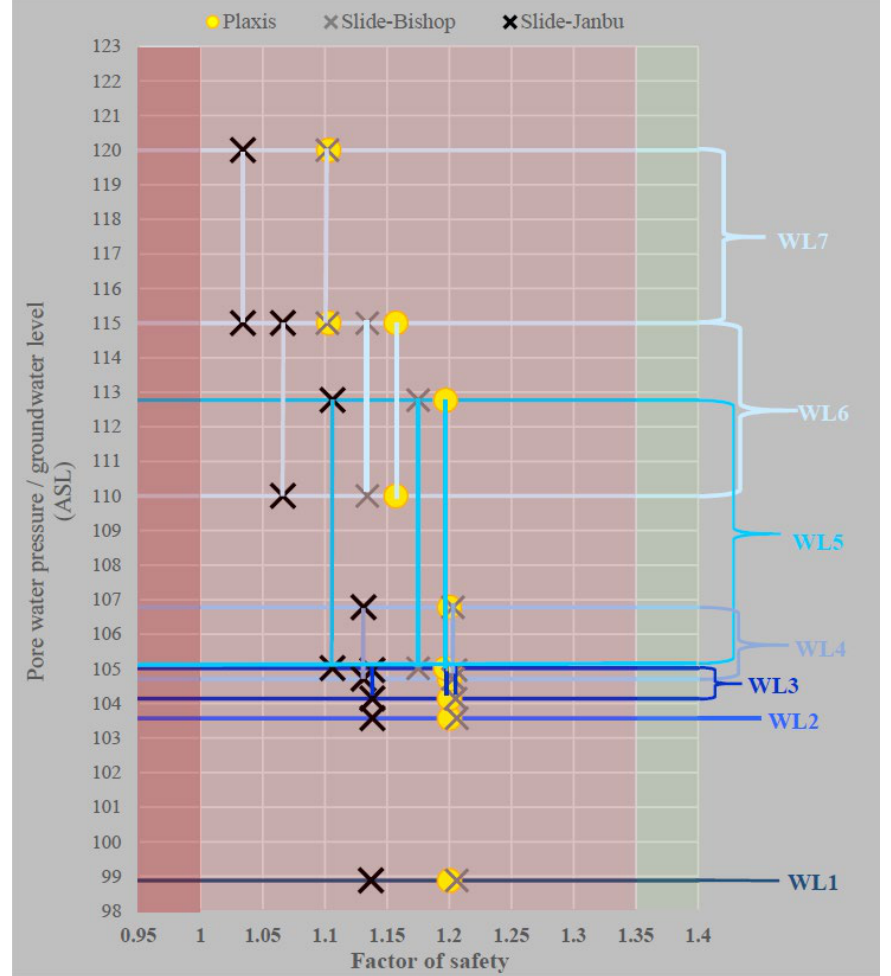
Figure 12. The change in safety factor as a result of the different modeled water levels in Plaxis and Rocscience (Bishop and Janbu simplified) software.